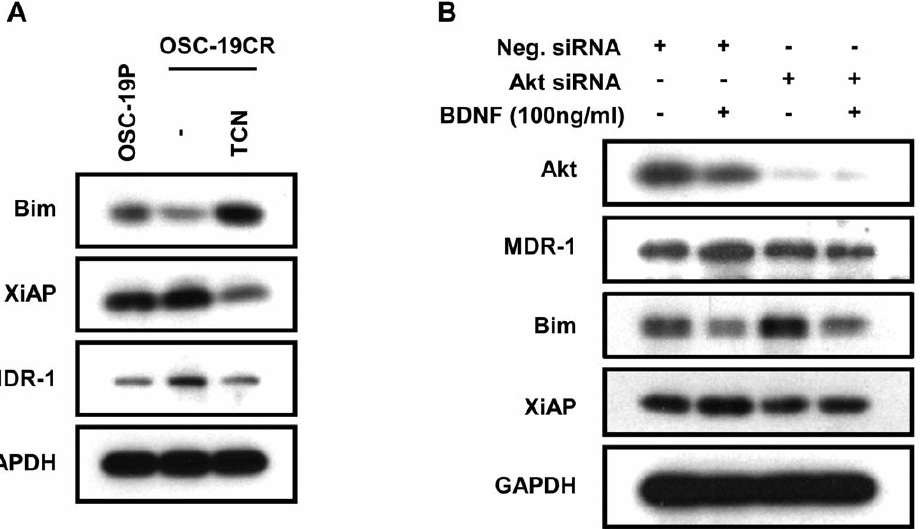
Figure 6. Akt plays a critical role in TrkB-induced CDDP-resistance development. A . OSC-19CR cell lysate following treatment with 5 uM of TCN, an Akt inhibitor, was collected and separated with SDS-PAGE to determine expression levels of Bim, XiAP, and MDR1. B . Expression levels of Bim, XiAP, and MDR1 were determined with cell lysate following transfected with siRNA against role of Akt in CDDP-resistance development in HNSCC.